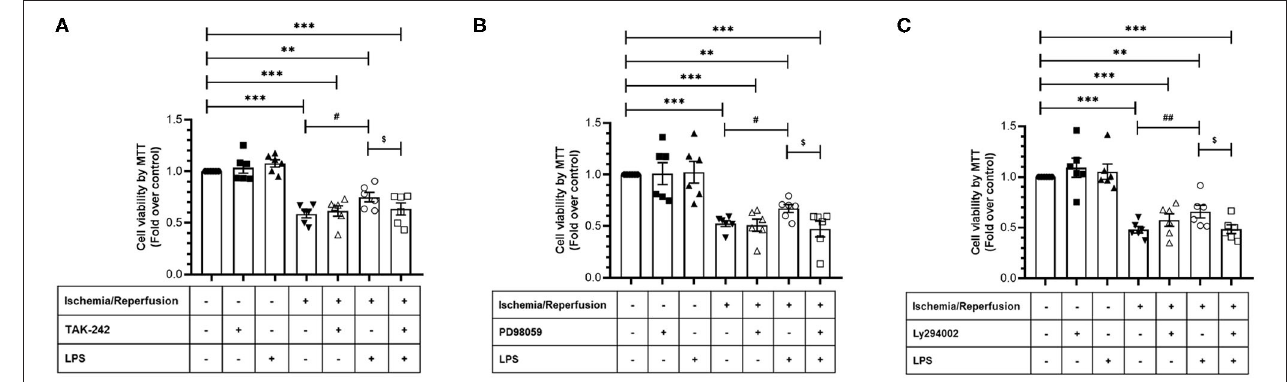
FIGURE 6 | Effect of TLR4 blockade, ERK1/2, and AKT inhibition on the loss of viability induced by ischemia/reperfusion (I/R) in cardiac fibroblasts treated with lipopolysaccharide (LPS). Cardiac fibroblasts were treated with LPS (1 µ g/ml) in the presence of (A) TAK-242 (4 µ M), (B) PD98059 (25 µ M), or (C) LY294002 (10 µ M). Cell viability was determined by the MTT assay. Results are expressed as mean ± SEM of six independent experiments. *** p < 0.001 and ** p < 0.01 vs. control; # p < 0.05 and ## p < 0.01 vs. sI/R; $ p < 0.05 vs. sI/R +